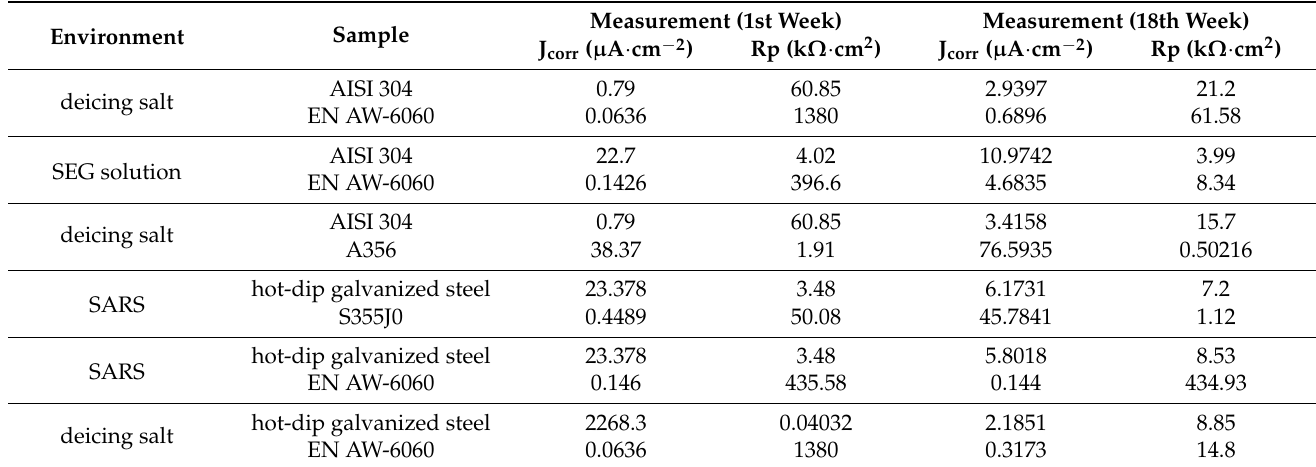
Table 6. Measurement according to Tafel and